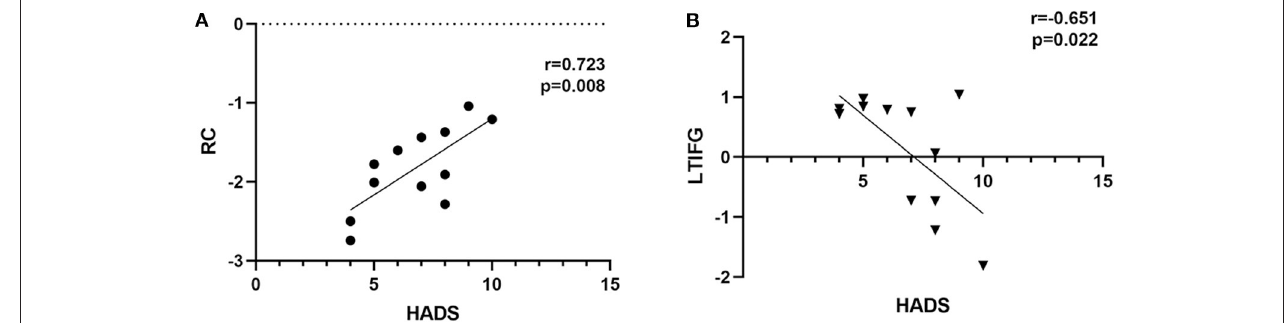
FIGURE 6 | Correlation analysis result. (A) The fALFF values in the right cerebellum of PAT presented significantly positive correlation with HADS (r = 0.723, P = 0.008). (B) The fALFF values in the left triangle inferior frontal gyrus of PAT presented significantly negative correlation with HADS (r = − 0.651, P = 0.022). fALFF, fractional amplitude of low-frequency fluctuations; HADS, hospital anxiety and depression scores; PAT, MGD patient in SO population.